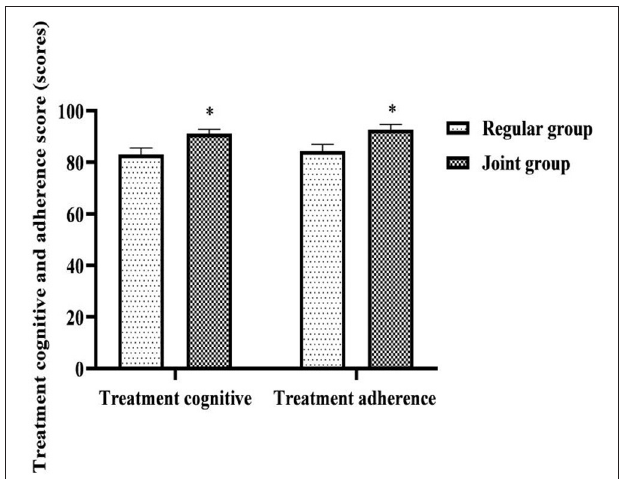
FIGURE 1 | Comparison of cognitive and adherence scores of comprehensive treatment of the two groups. Compared with the same item in the regular group, * P <